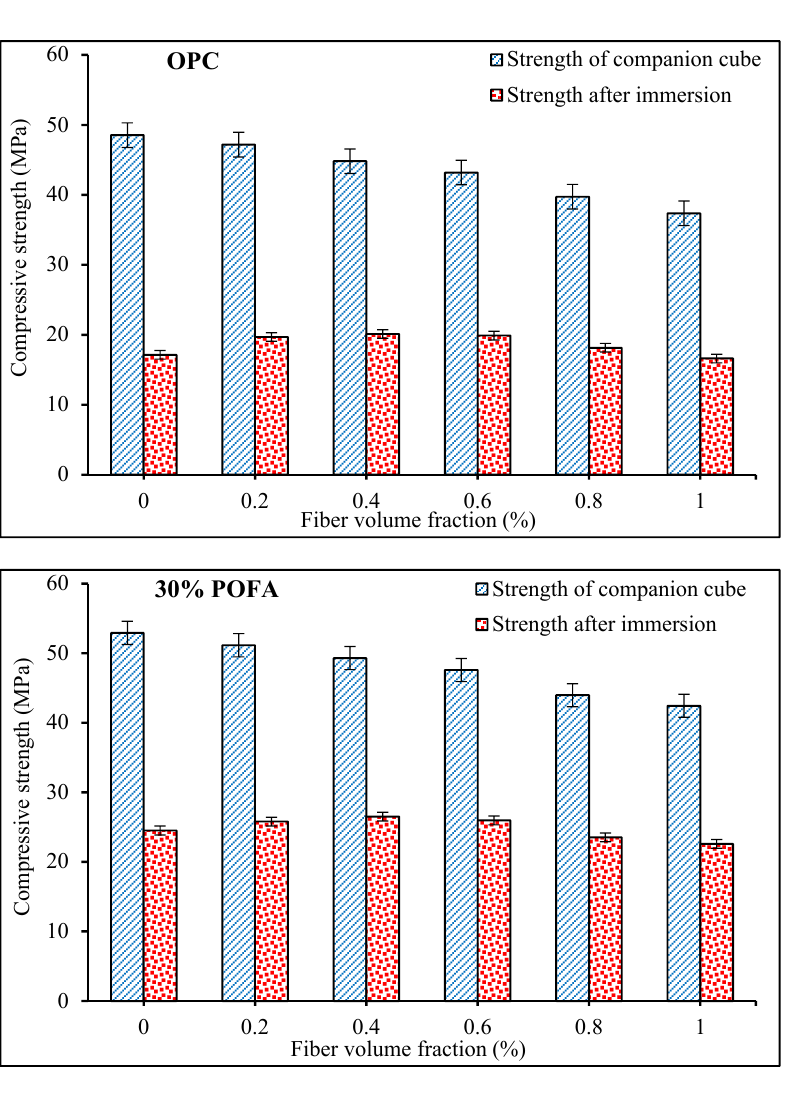
Figure 14. The variation in the 365-day compressive strength of concrete mixtures containing WPFT fibers exposed to a H 2 SO 4 solution. Crystals 2021 , 11 , x FOR PEER REVIEW